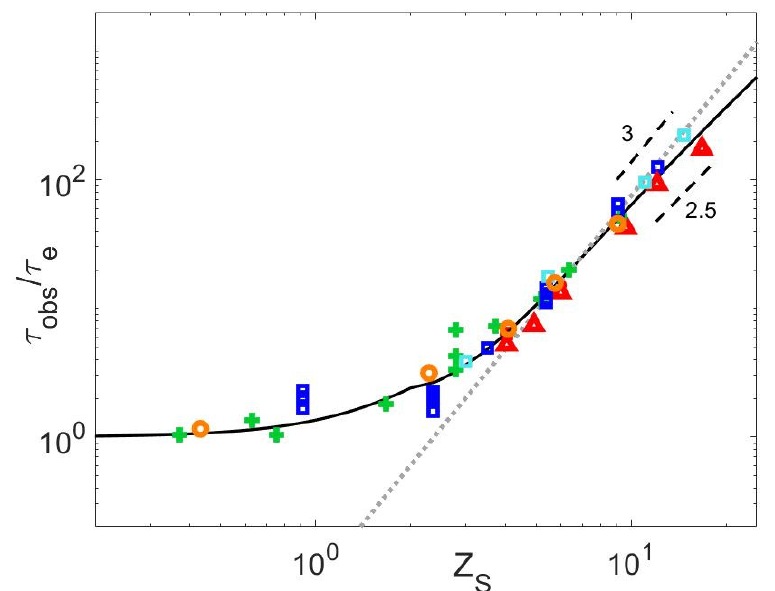
Figure 11. Normalized τ obs data of all available datasets for PS (green +), PI (red ∆ ) PMMA (orange ○ ) and PBD (blue ) as a function of Z S , compared to Equation (26) (continuous black line), and the scaling τ obs = K W τ e Z 3 with K W = 0.075 (grey dotted S